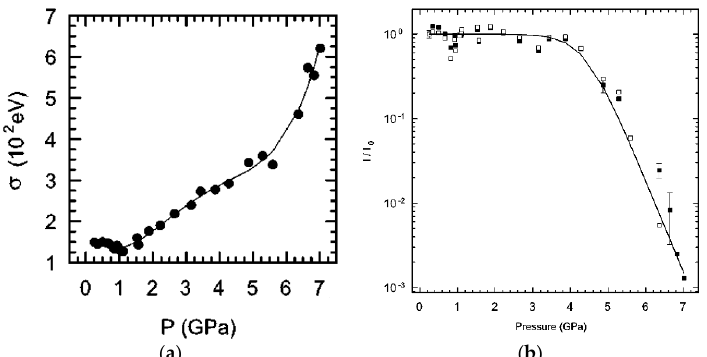
Figure 13. Intrinsic photoluminescence in γ -InSe under high pressure. ( a ) Pressure dependence of the PL peak width. ( b ) Pressure dependence of the photoluminescence peak intensity [67].